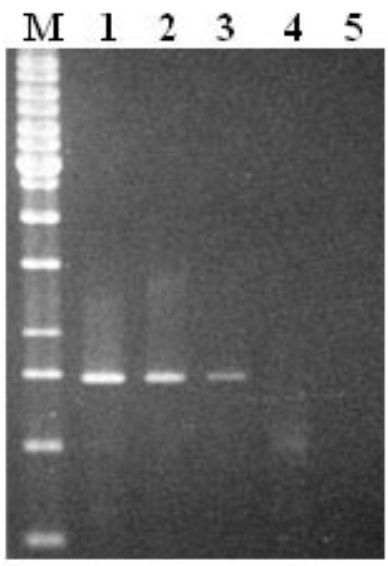
Figure 2. Agarose gel electrophoresis of RT-PCR of the coat protein from 2 CVV isolates. Lane 1, positive sample; lane 2, Campania Zagara; lane 3, Campania Ovale; lane 4, healthy sample; lane 5, no DNA; M, 1kb ladder DNA